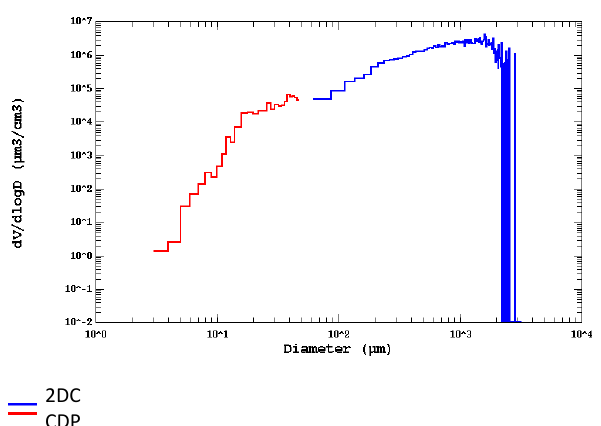
Fig. 9. Particle volume distribution for the period 22:25:45 to 22:26:45 from the CDP (red) and 2DC instruments (blue). (Water- based channel boundaries for the CDP are plotted here).